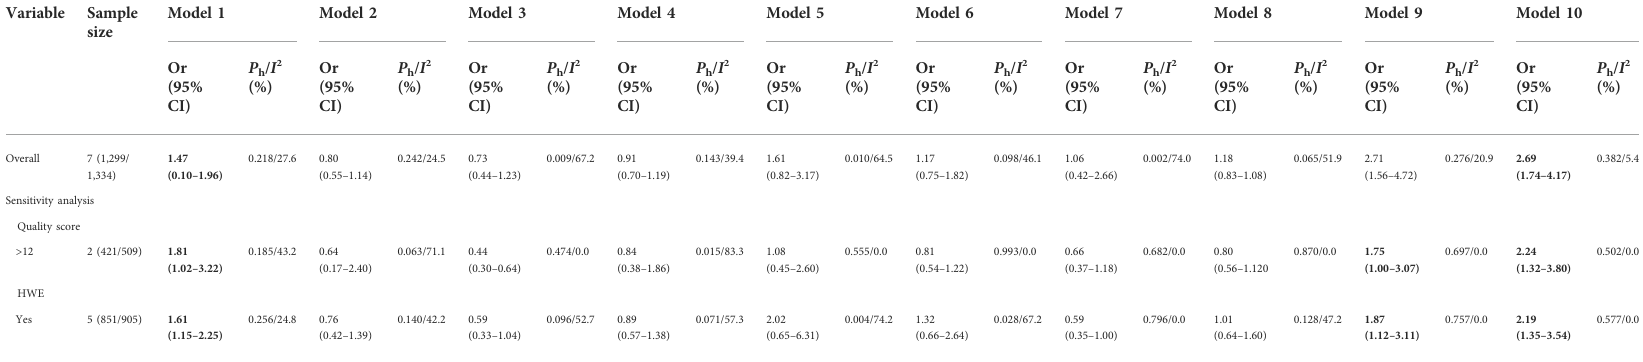
TABLE 7 Meta-analysis of the combined effects of GSTM1 present/null, GSTT1 present/null and GSTP1 present/null on T2DM